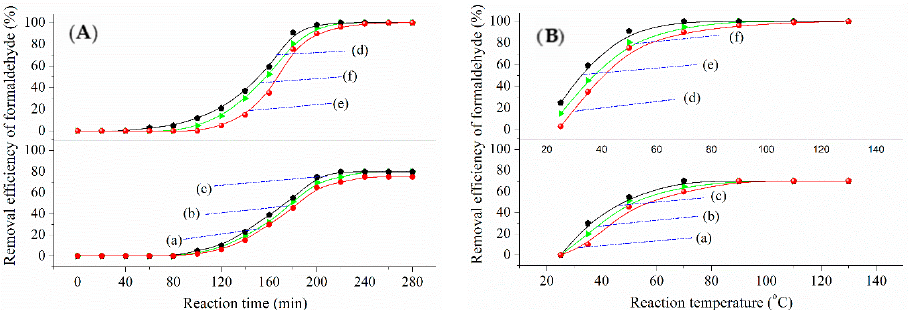
Figure 9. Effect of reaction time ( A ) and temperature ( B ) on the catalytic performance of catalysts . (a) 0.005BiOCl/MnMgAl-HT, (b) 0.01BiOCl/MnMgAl-HT, (c) 0.015BiOCl/MnMgAl-HT, (d) 0.005BiOCl/MnMgAlO, (e) 0.01BiOCl/MnMgAlO and (f) 0.015BiOCl/MnMgAlO.